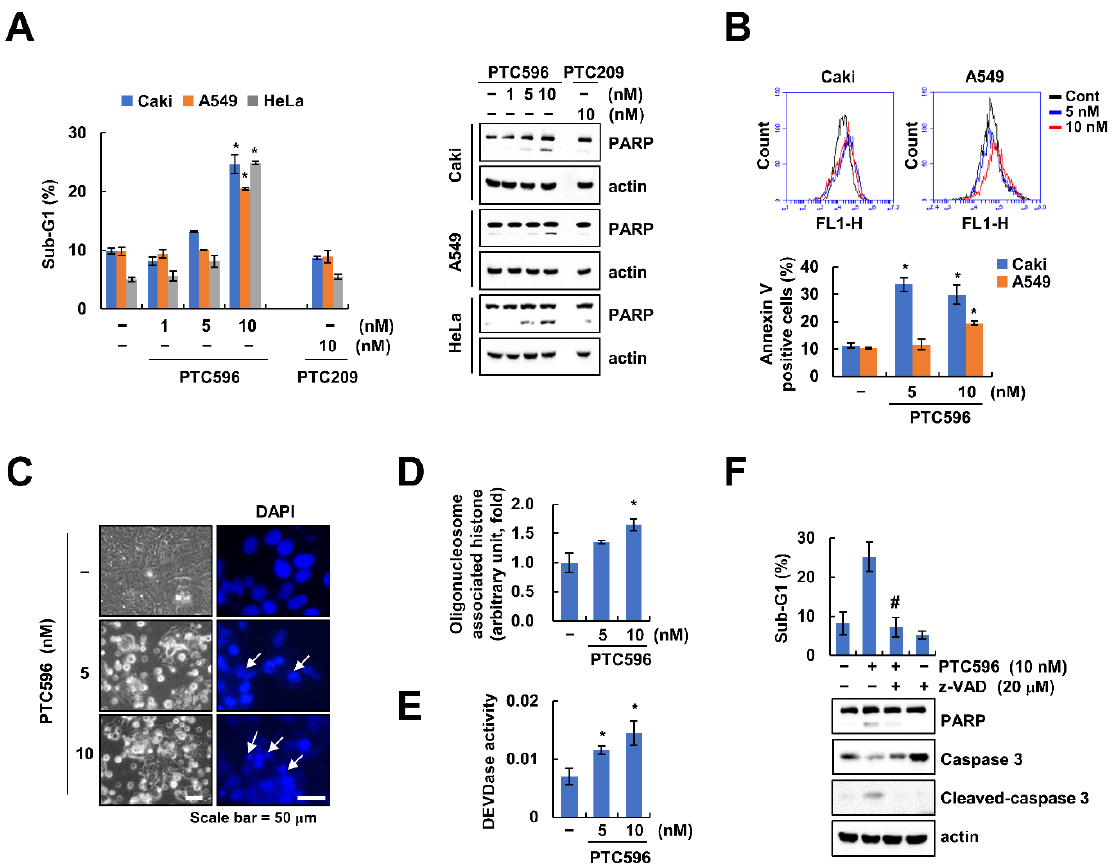
Figure 2. PTC596 induces apoptosis in a caspase-dependent manner. ( A ) Cancer cells (Caki, A549 and HeLa) were treated with PTC596 (1, 5, 10 nM) or PTC209 (10 nM) for 24 h; ( B – E ) Caki ( B – E ) and A549 ( B ) cells were treated with PTC596 (5, 10 nM) for 24 h. Cell death was determined by staining with Annexin V-FITC dye ( B ). Cell morphology and nuclear condensation were examined using a microscope ( C ). Fragmentation of the nuclei was examined using a DNA fragmen- tation assay kit ( D ). Caspase-3 activity was detected using DEVDase substrate ( E ); ( E , F ) Caki cells were pre-treated with z-VAD-fmk (z-VAD, 20 μM) and then treated with PTC596 (10 nM) for 24 h. The sub-G1 population and protein expression were measured by flow cytometry and Western blotting, respectively. The values in graphs ( A , B , D – F ) represent the mean ± SD of three independent samples. * p . < 0.05 compared to the control. # p. < 0.05 compared to the treatment of PTC596.